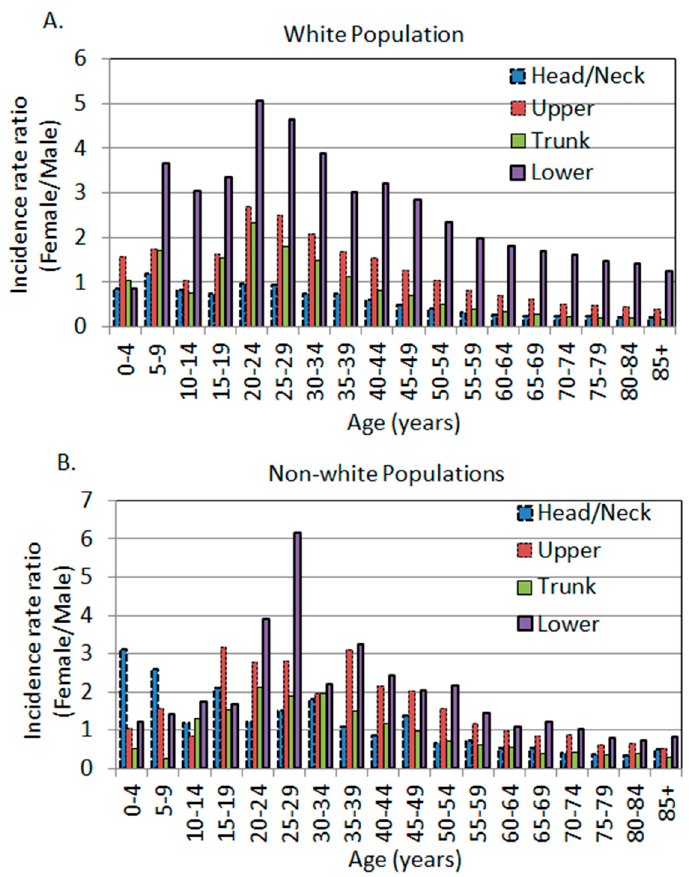
Figure 2. The age-specific female to male incidence rate ratios by anatomic site. ( A ) White population. ( B ) Non-white populations, including black Americans, Hispanics, American Indians/Alaska Natives, and Asian Americans/Pacific Islanders (SEER 18 data,